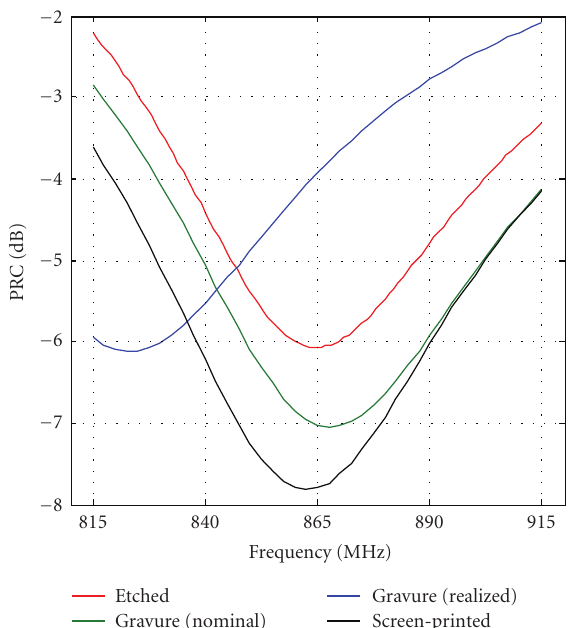
Figure 7: PRC’s of di ff erent antenna models according to the simulated antenna impedances.